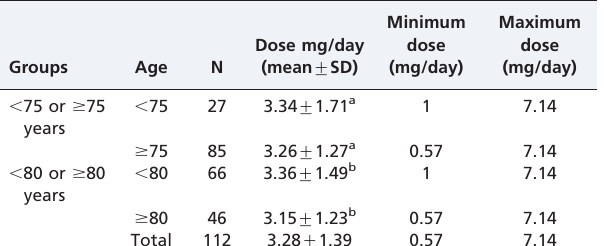
Table 1 - Daily warfarin doses in 112 patients with atrial fibrillation undergoing oral anticoagulation.